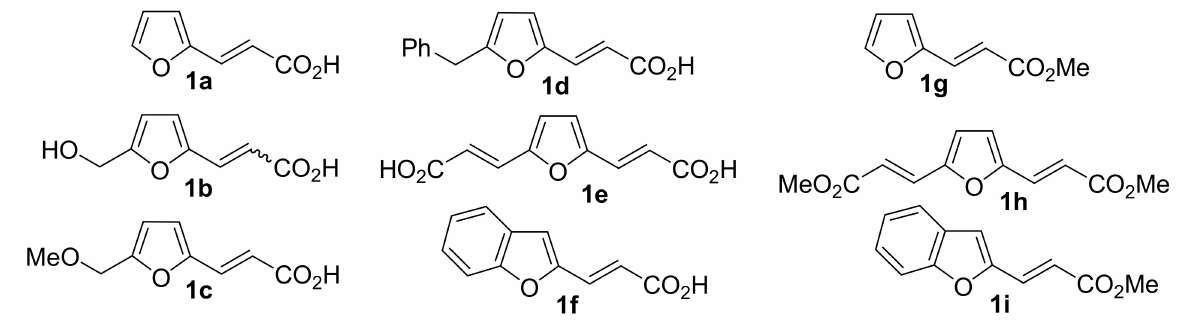
Figure 1. Starting 3-(furan-2-yl)propenoic acid derivatives 1a – i used in this